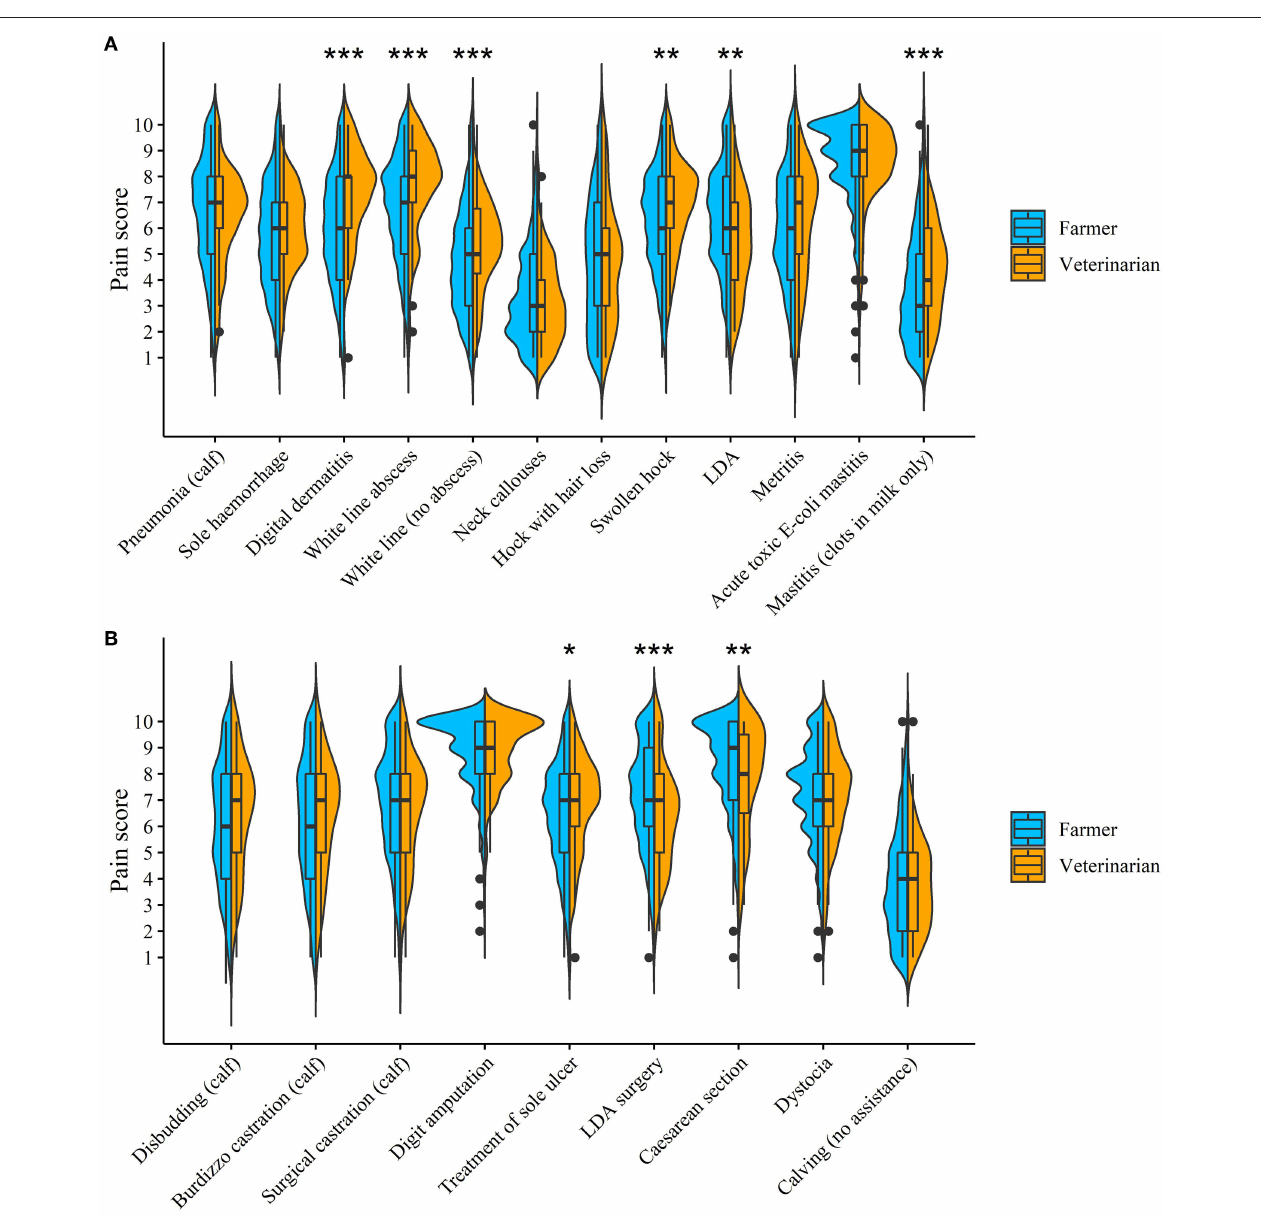
FIGURE 1 | Violin plots showing the distribution of pain scores for different conditions (A) and procedures (B) split for farmers and veterinarians, in a survey investigating attitudes to pain and analgesic use in pasture-based dairy cows. Overlaid boxplots show the median and interquartile range. Significant differences in pain scores between veterinarians and farmers are indicated (*** P < 0.001, ** P < 0.01, * P <